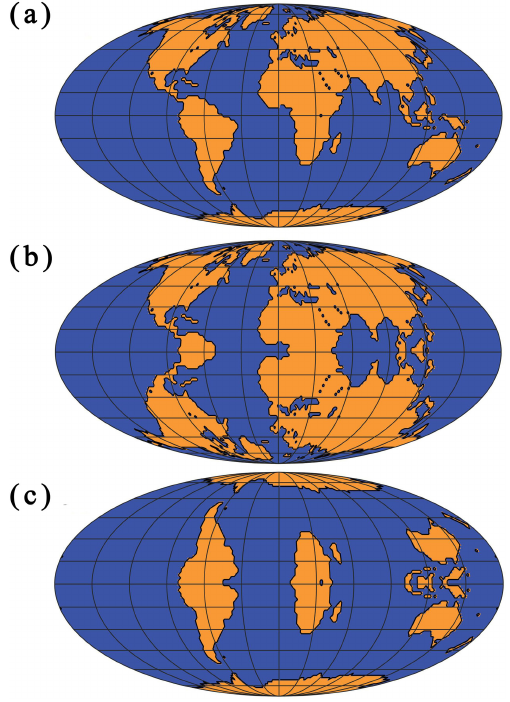
Figure 2. (a) modern continental geography, (b) NORTH-SYMM geography and (c) SOUTH-SYMM